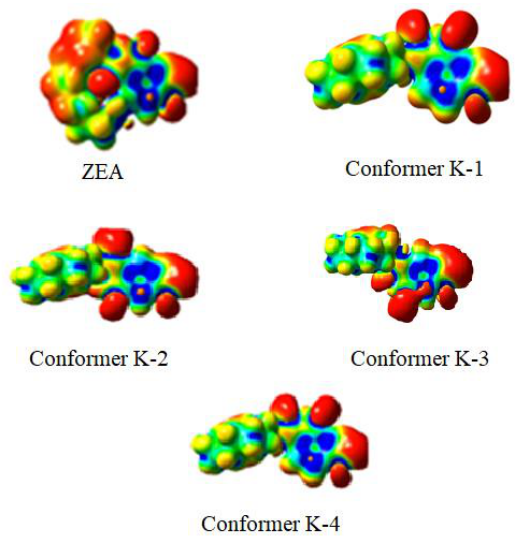
Figure 4. Maps of electrostatic potentials calculated using the DFT method for ZEA and CDHB (K-1 to K-4). The GaussView 4.0 code was used for visualization.